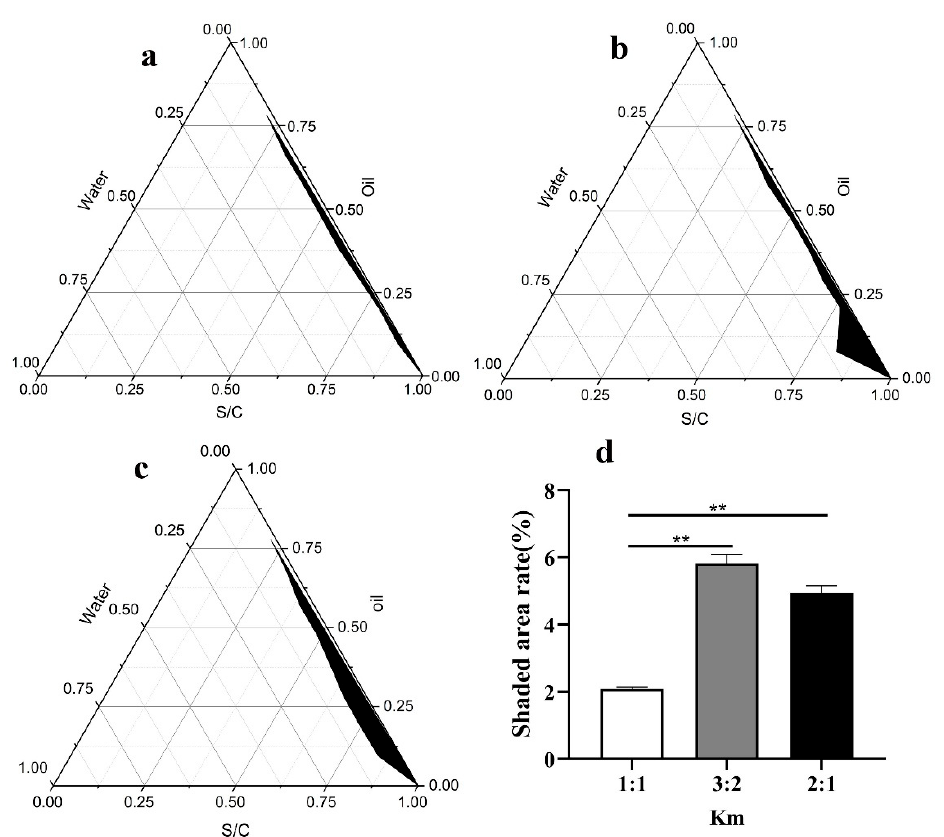
Figure 2. Pseudo-ternary phase diagram for different Km values ( a ) Km = 1:1. ( b ) Km = 2:1. ( c ) Km = 3:2. ( d ) The ratio of the shaded area to the area of the ternary phase diagram for the different Km values. (based on the ( a – c )). ** p < 0.01. Notes: Km indicates the relative ratio of the surfactant (Span85 and Tween60) and the co-surfactant (PEG-400).